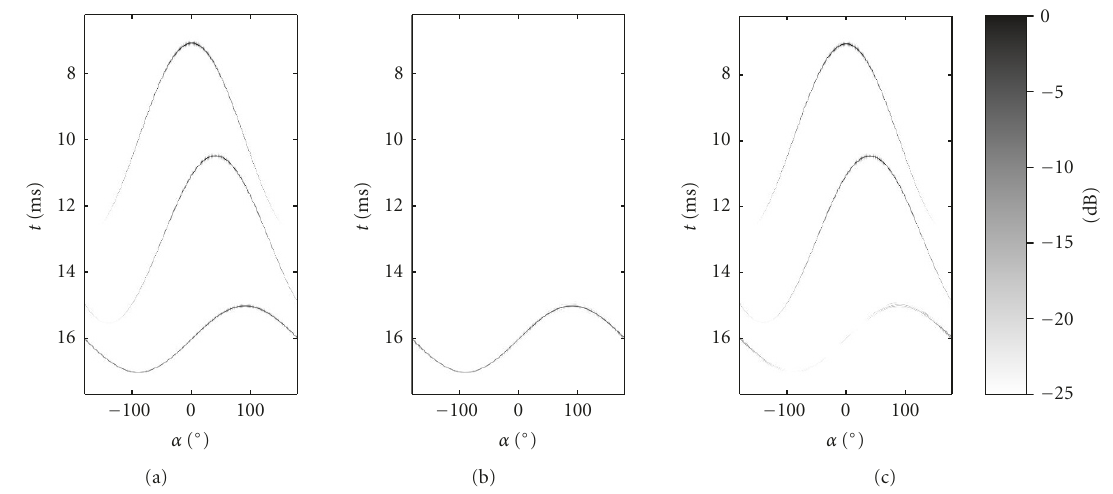
Figure 7: (a) The simulated input data set, (b) the reconstructed response of the wave with elevation angle θ = 70 ◦ , and (c) the result of subtracting the reconstructed response from the original data.